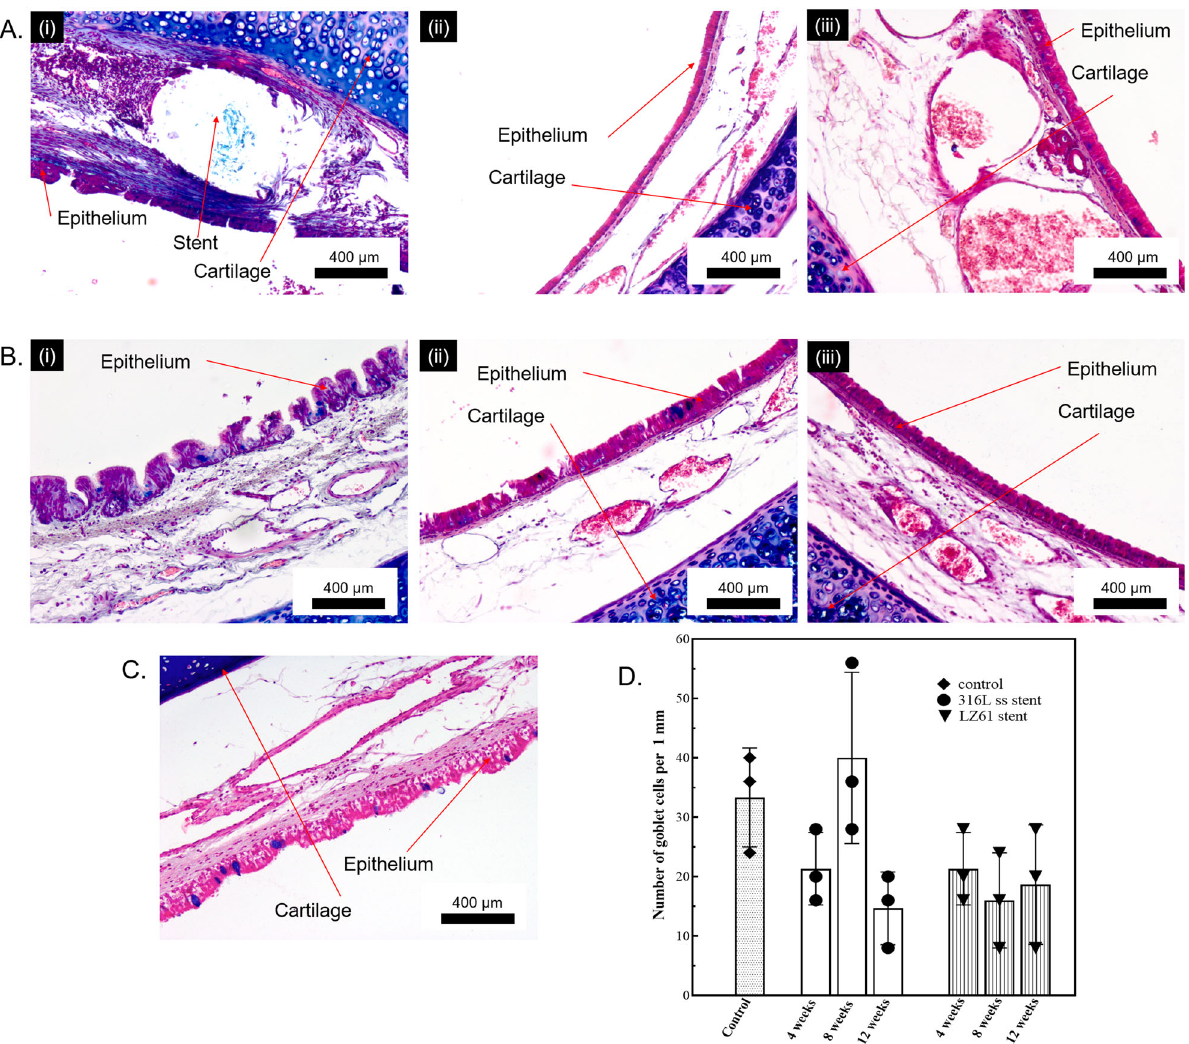
Fig. 5 Alcian blue staining of stented rabbit trachea. A LZ61-KBMS stent stented trachea. (i) 4 weeks, (ii) 8 weeks and (iii) 12-weeks post implantation, B 316L SS stent stented trachea (i) 4 weeks, (ii) 8 weeks and (iii) 12-weeks post implantation, C Healthy trachea, D number of goblet cells per 1 mm along the epithelium. No statistical difference was identi fi ed among the different groups ( P > 0.05).